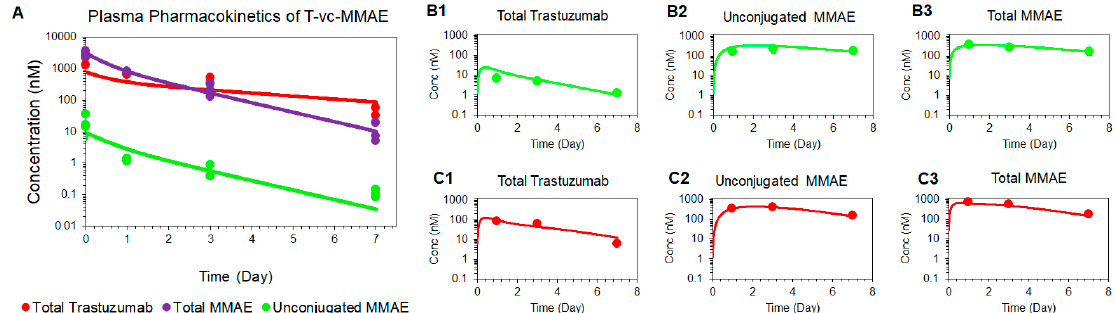
Figure 4. Model fittings for plasma and tumor pharmacokinetics of 10 mg/kg of intravenous 10 mg/kg T-vc-MMAE ( A ) Observed and model fitted profiles for plasma pharmacokinetics of total trastuzumab (red), total MMAE (purple), and unconjugated MMAE (green) in GFP-MCF7 and N87 tumor bearing mice. ( B and C ) Observed and model fitted profiles for tumor pharmacokinetics of total trastuzumab ( B1 and C1 ), free MMAE ( B2 and C2 ), and total MMAE ( B3 and C3 ) in GFP-MCF7 (green) and N87 (red) tumor bearing